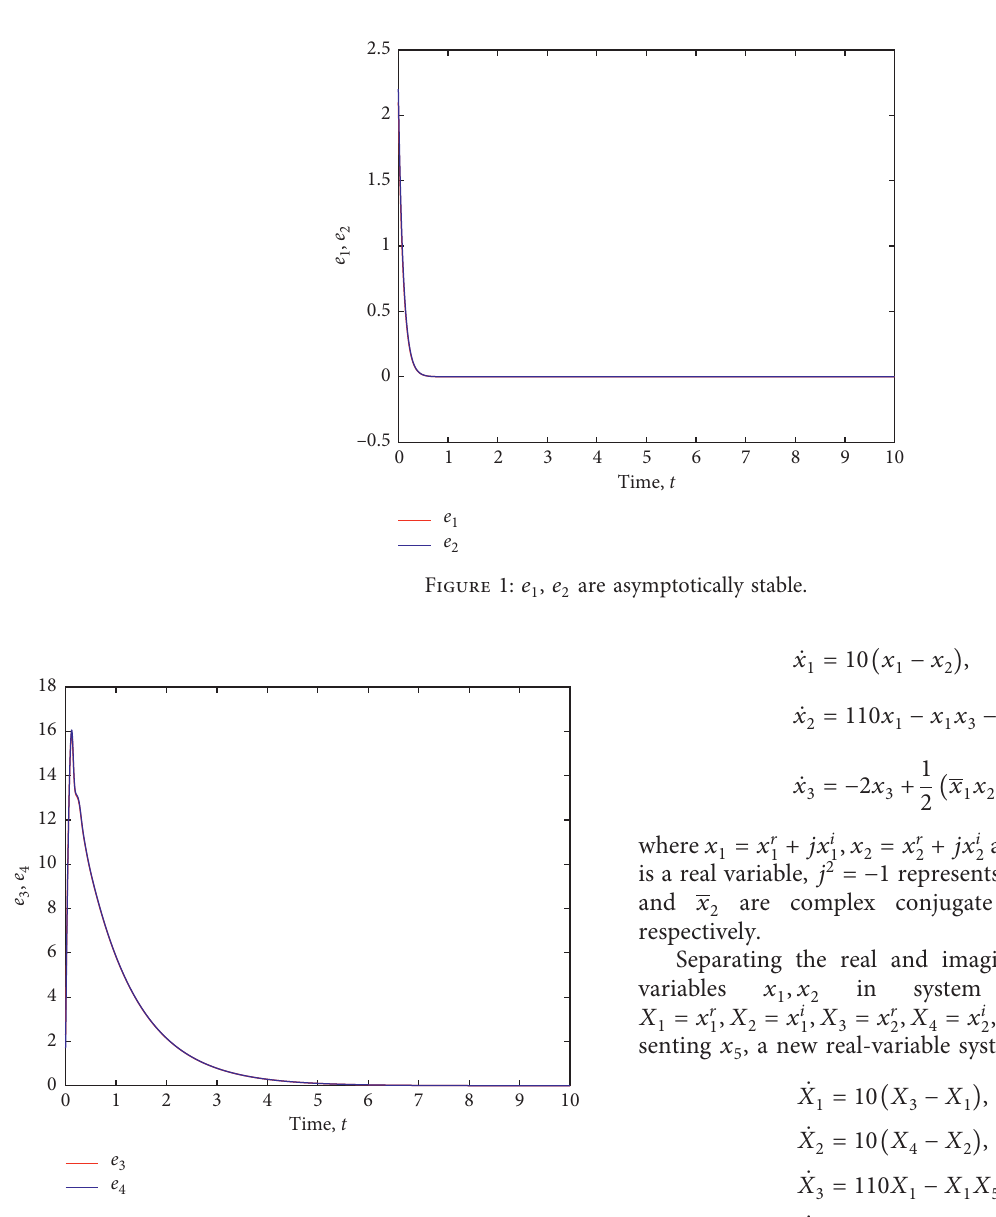
, e are asymptotically 3 4